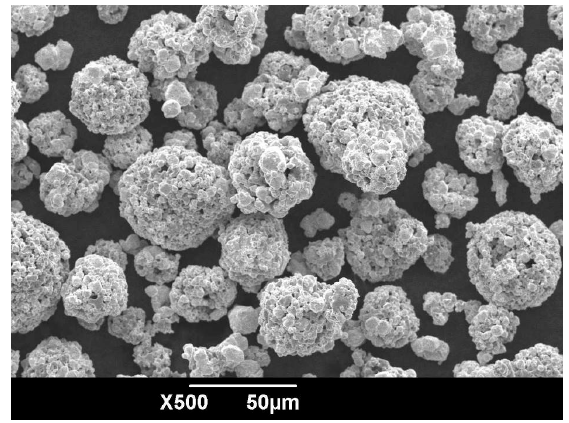
Figure 1. SEM morphology of WC-17Co powder